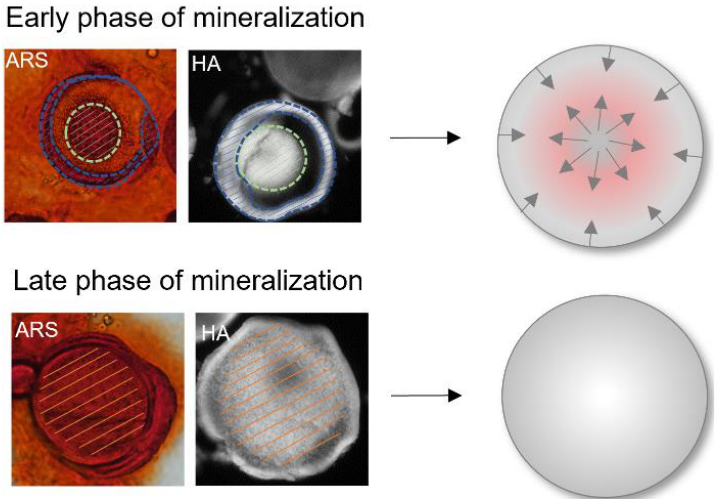
Figure 6. Close-up of cGM in the early and late mineralization phase stained with Alizarin Red staining (ARS) or OsteoImage (HA). The mineralized areas have been marked with dashed lines in green for the inner mineralization zone, in blue for the outer mineralization zone, and orange for completely mineralized particles.